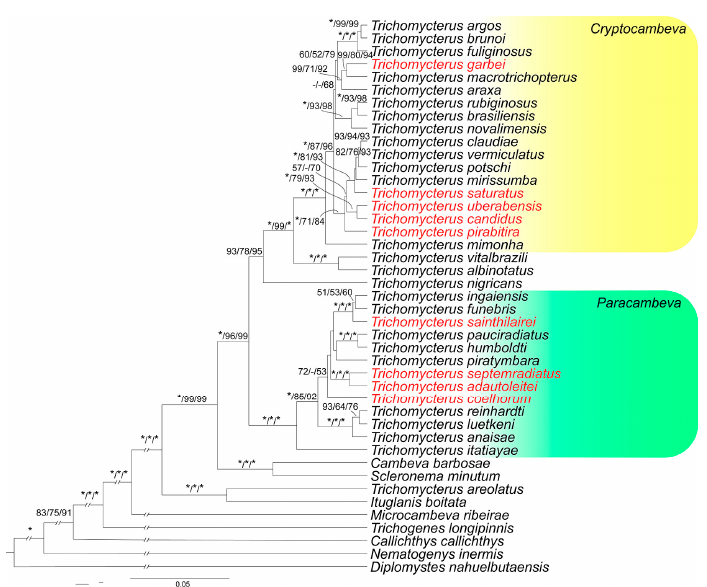
Figure 1. Bayesian Inference tree estimated by Beast for 47 taxa, using 3 genes (COI, CYTB, and RAG2), with a total of 2600 bp. The numbers above the branches indicate Bayesian posterior probabilities of the Bayesian Inference analysis, and bootstrap and fast bootstrap values of the Maximum Likelihood analyses, respectively, separated by bars. Asterisks (*) indicate maximum support values, and dashes (-) indicate values below 50. Taxa in red are species from the Middle Rio Grande